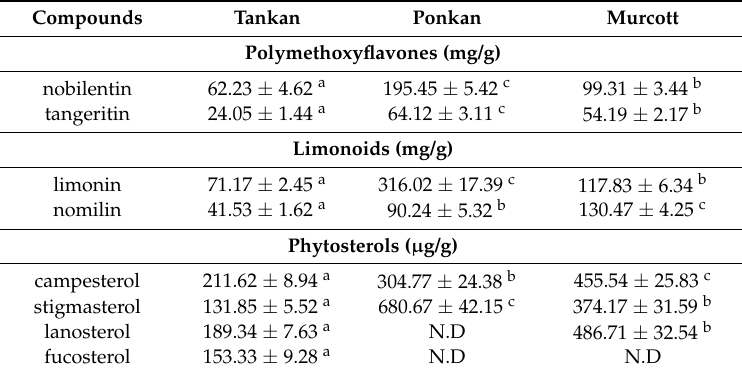
Figure 1. Analysis of flavonoid ( A ) and limonoid ( B ) by HPLC. Table 2. Non-volatile composition of citrus